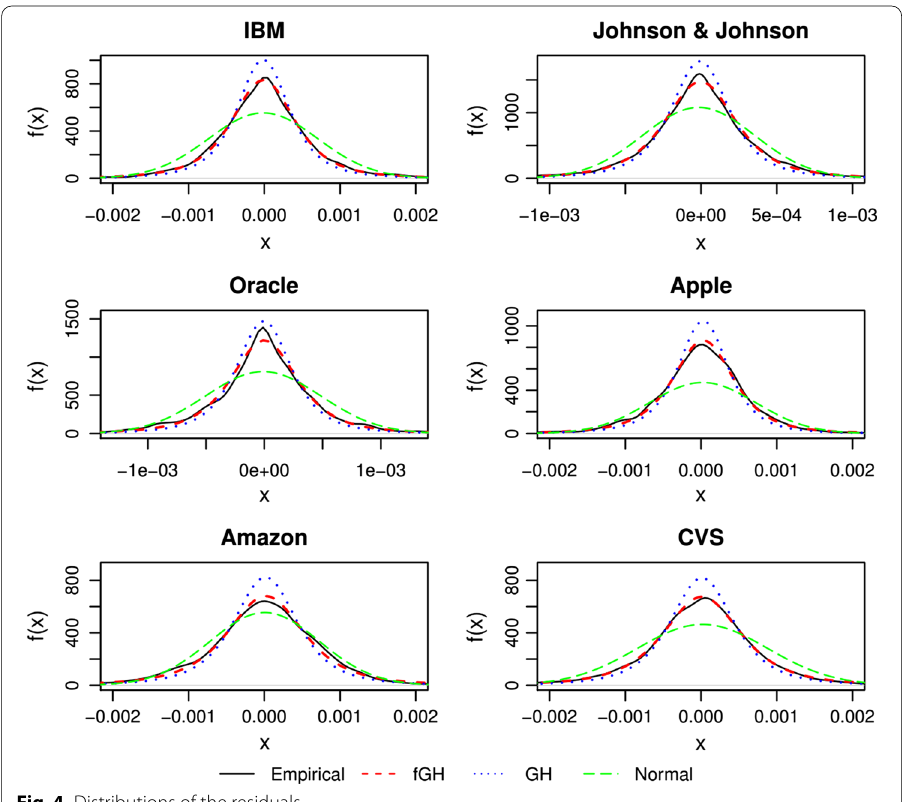
Fig. 4 Distributions of the